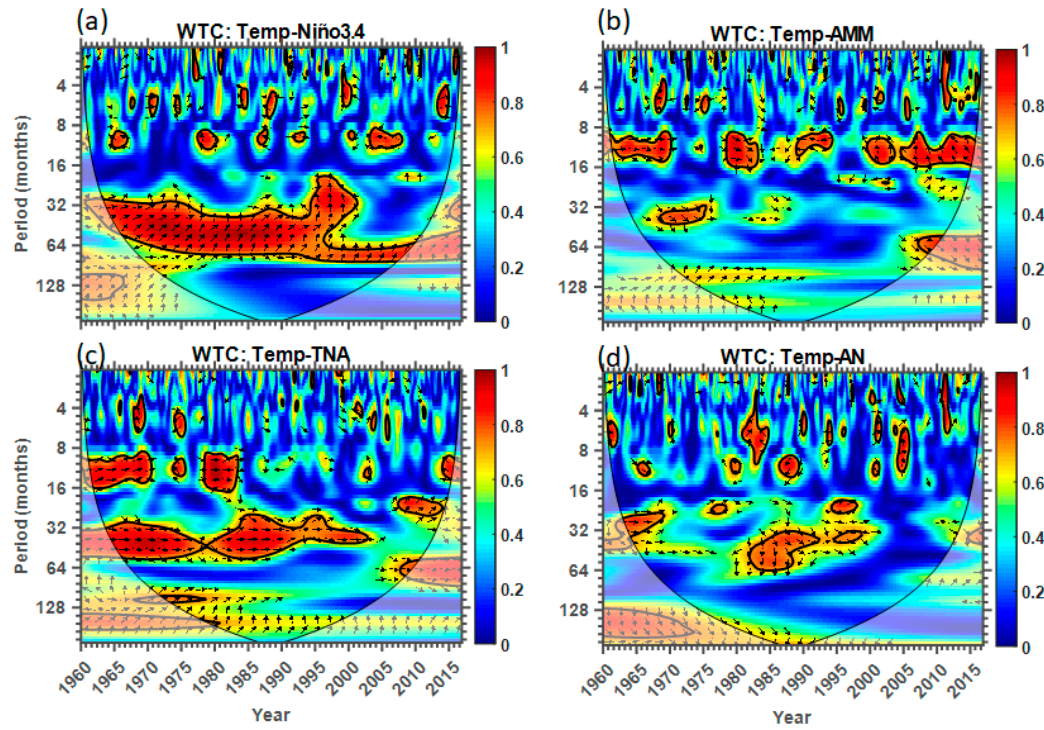
Figure 12. Wavelet coherence between temperature and Niño 3.4 ( a ), AMM ( b ), TNA ( c ) and AN ( d ) 1960–2016, the phase relationship is represented by arrows. The black solid line contour delimits the region (red) where the power is strong and significant and the cone of influence (solid black line) indicates the 95% confidence level.